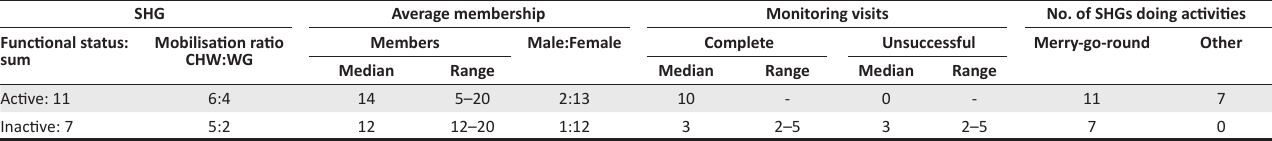
TABLE 1: Summary of compliance with implementation across active and inactive groups post-registration. SHG Average membership Monitoring visits No. of SHGs doing